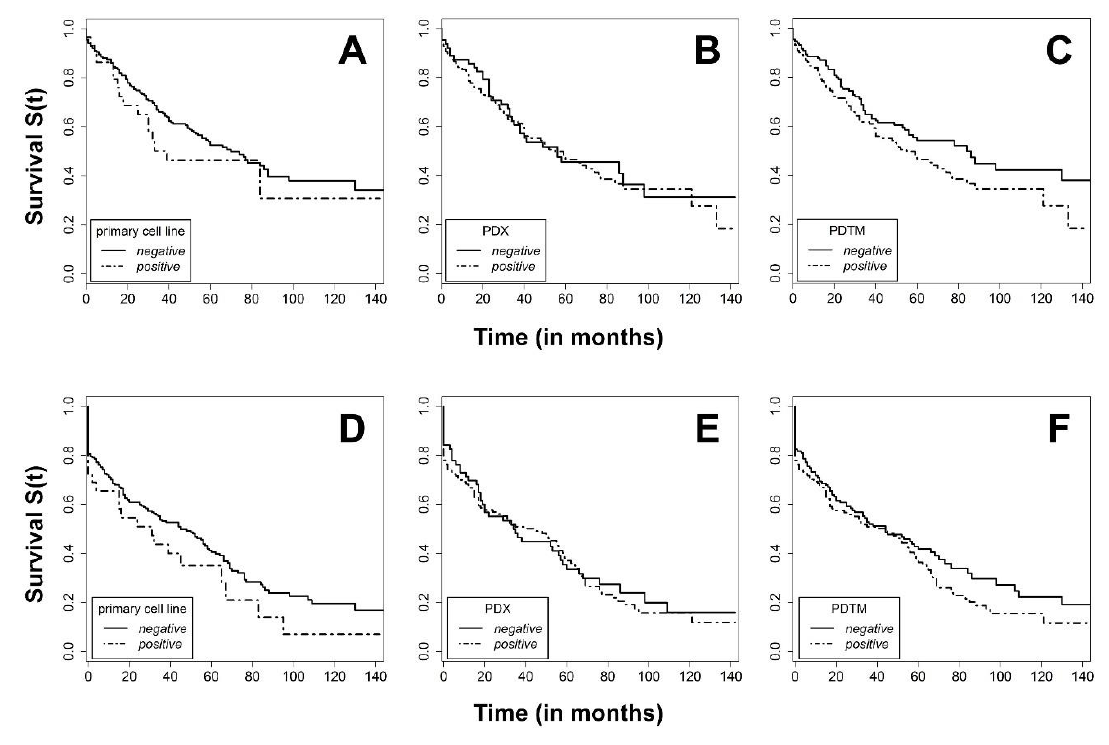
Figure 2. Kaplan–Meier curve for overall survival (OS) (top) of patients for whom ( A ) a primary cell line, ( B ) a PDX, or ( C ) any type of model could be established from their respective tumor tissue and relapse-free survival (RFS, bottom) of patients for whom ( D ) a primary cell line, ( E ) a PDX or ( F ) any type of model (patient-derived tumor model, PDTM) could be established from their respective tumor tissue (positive line) or not (negative